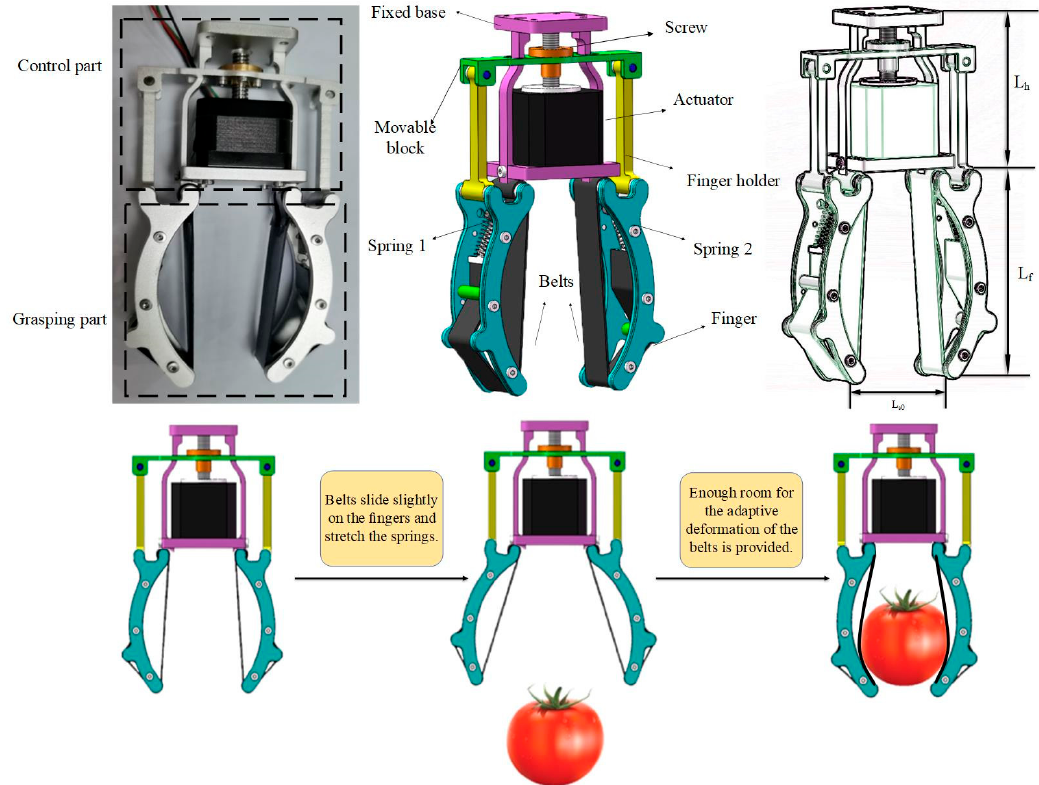
Figure 1. The constituent part and the grasping process view of robotic ripper.